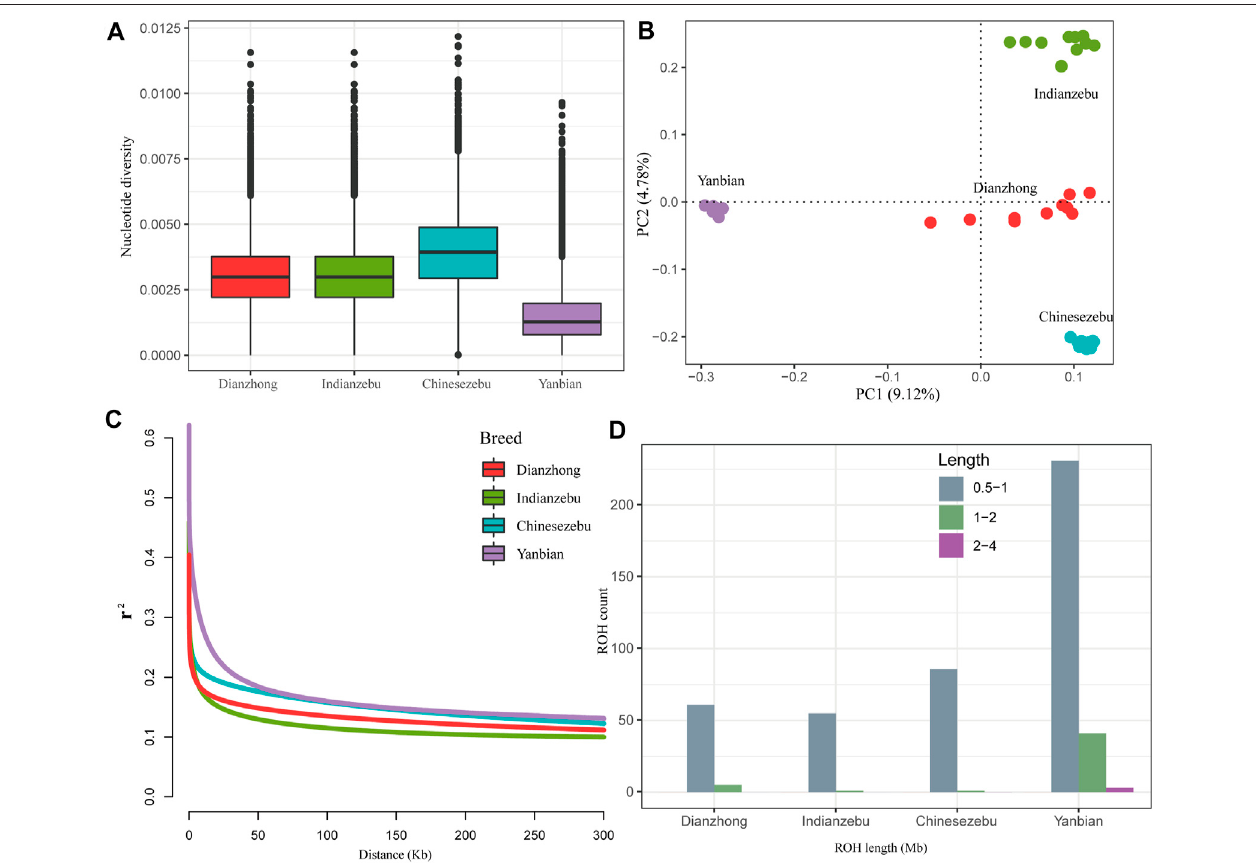
FIGURE 1 | Summary statistics for genomic diversity. (A) Genome-wide distribution of nucleotide diversity of each group. The horizontal line inside the box indicated the median of this distribution; box limits indicated the fi rst and the third quartiles, points showed outliers. Data points outside the whiskers can be considered as outliers. (B) Principal component analysis of four cattle groups. (C) Genome-wide average LD decay estimated from each group. (D) The estimation of number and length of ROH for each